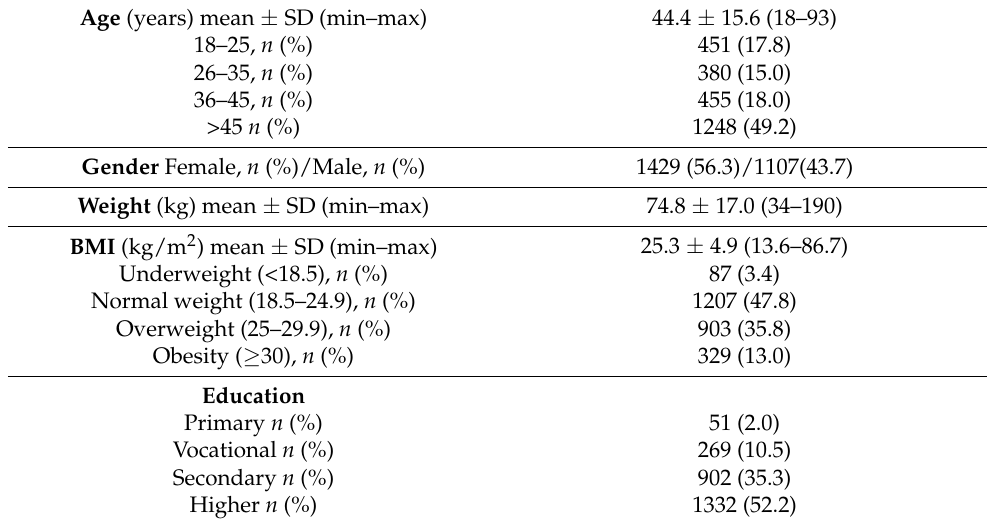
Table 1. Demographic breakdown of surveyed participants ( n =